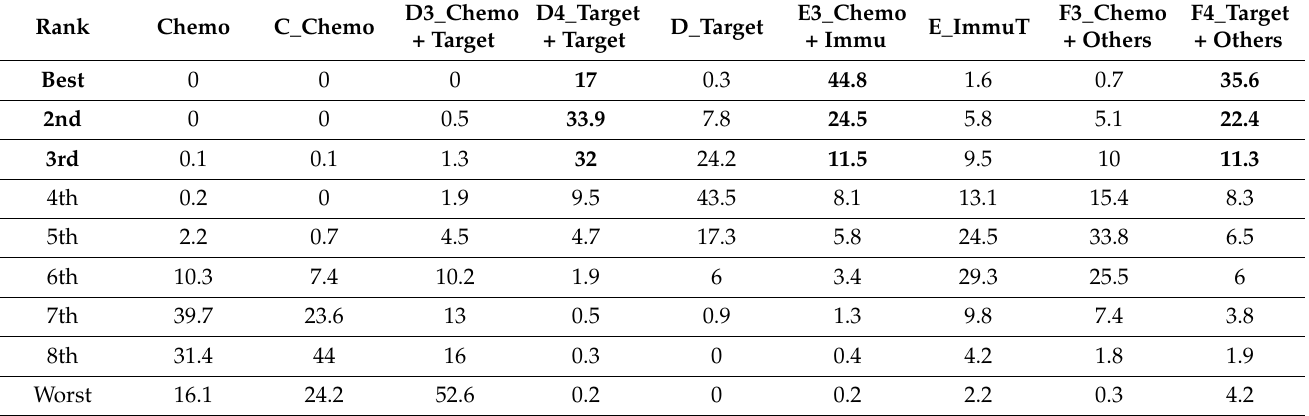
Figure 3. Network map of response rate/disease-free control rate (advanced stage). Table 3. Estimated cumulative probabilities (%) of each treatment being the best in response rate (Advanced stage, Component I).